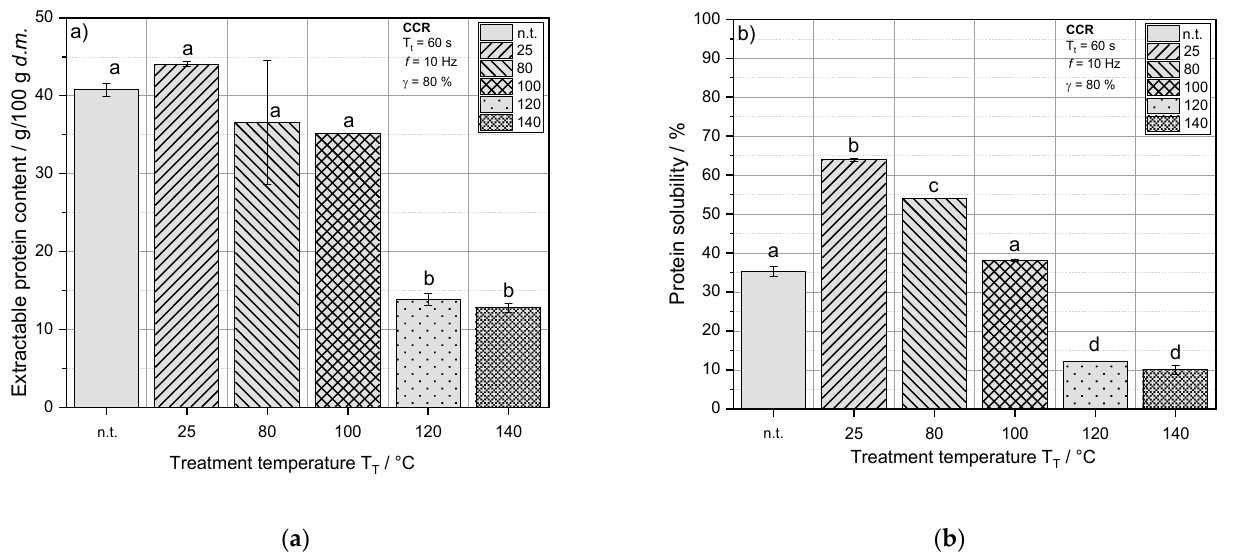
Figure 2. ( a ) Extractable protein content (g/100 g d.m.) and ( b ) protein solubility (%) at a pH of 7 as a function of the treatment temperature T T of rapeseed press cake (RPC). Mean values with different superscript letters indicate significant differences ( p < 0.05) based on a one-way analysis of variance (ANOVA). Where appropriate, the mean values were compared using Tukey’s honest significance test. n.t. = not treated.